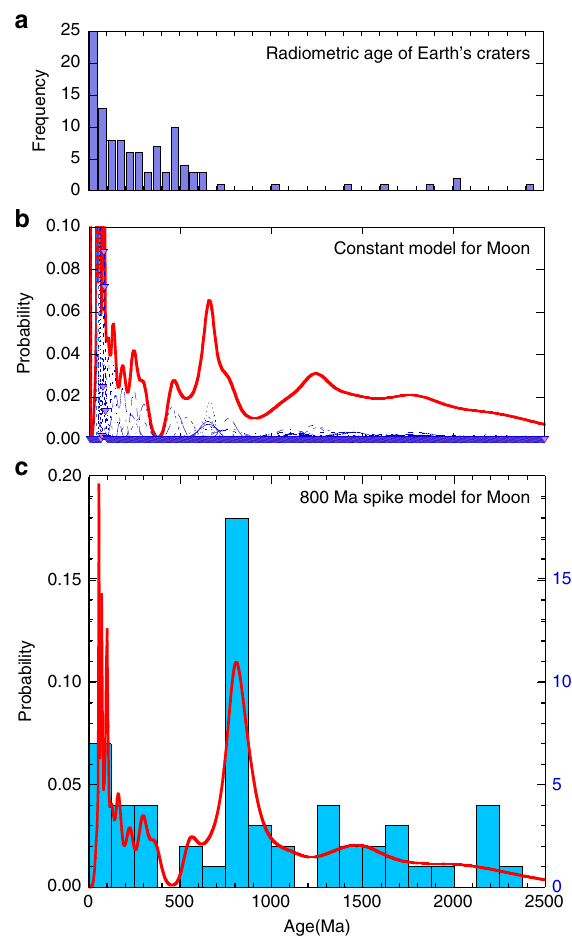
Fig. 3 The age distributions of terrestrial craters and lunar craters. a is a histogram of radiometric ages of terrestrial craters, b is the relative probability of 59 crater ages investigated based on the conventional constant fl ux, and c shows the relative probability and histogram of 59 crater ages based on the 800 Ma spike